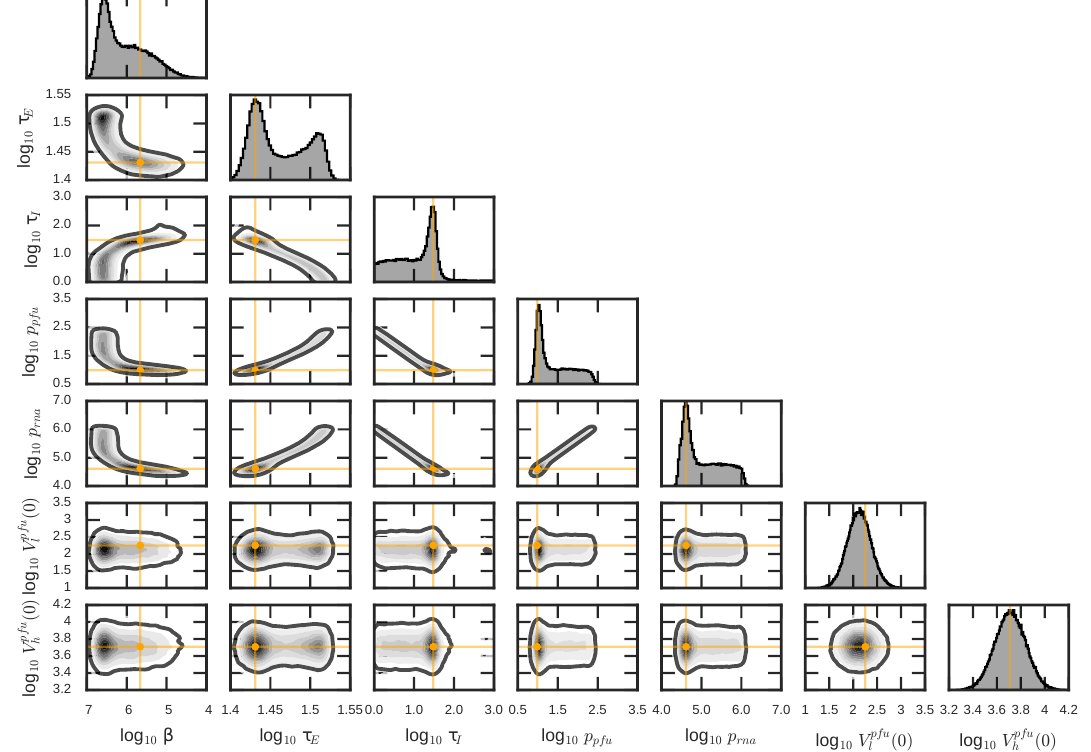
Figure 5. Parameter posterior distributions and pair-wise posterior plots obtained from MCMC run of the model (3) and (4). The orange targets indicate the best-fit parameter values given in Table 4. The solid dark lines enclose the 95% credible regions. Table 4. Parameter values obtained from fitting the Equations (3) and (4) to low and high MOI